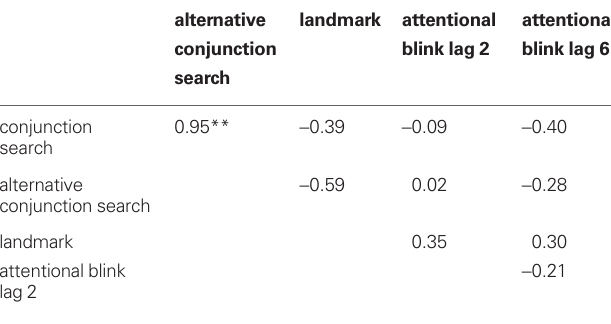
Table 2 | Pearson correlations between improvement scores on individual